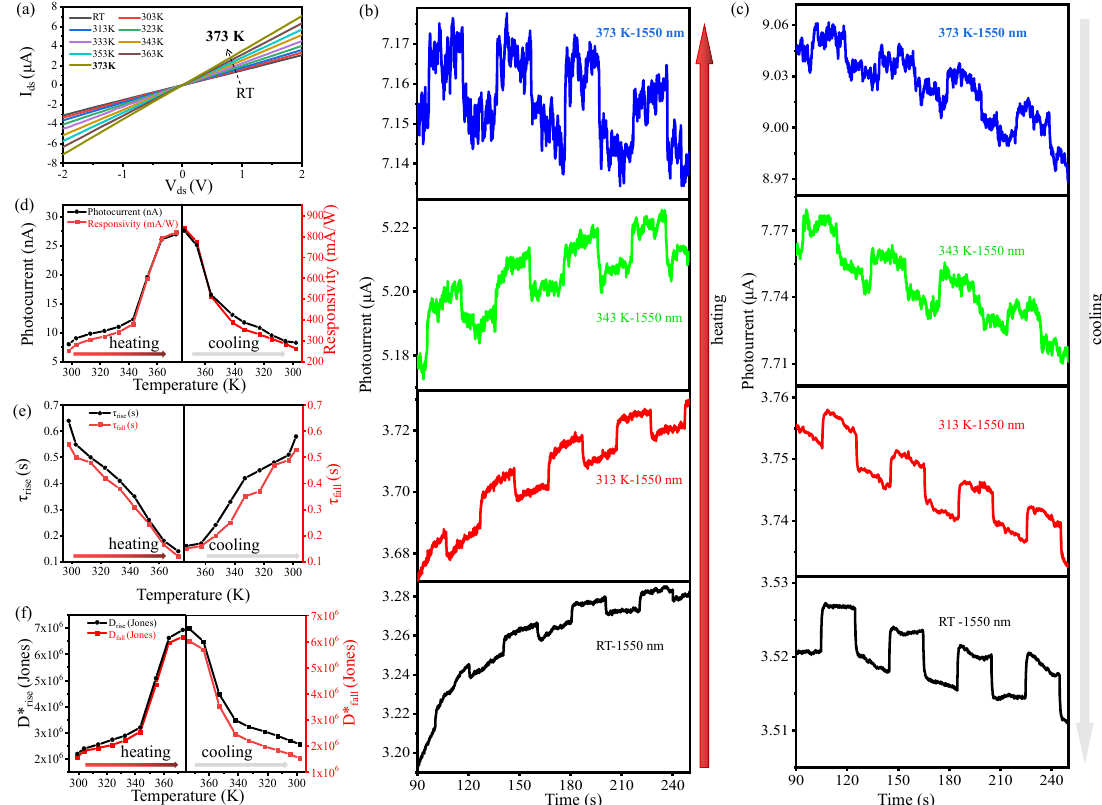
Figure 4. Temperature-dependent photoelectric properties of PtS 2 films. ( a ) I ds -V ds characteristic curve of PtS 2 FETs when heating up from room temperature to 373 K. ( b , c ) I ph as a function of illumination time at 1550 nm during the heating up and cooling process from 373 K to room temperature at several selected points. ( d - f ) I ph and R ( d ) , τ rise and τ decay ( e ), D * ( f ) of PtS 2 FETs at 1550 nm during the heating up and cooling from 373 K to room temperature.